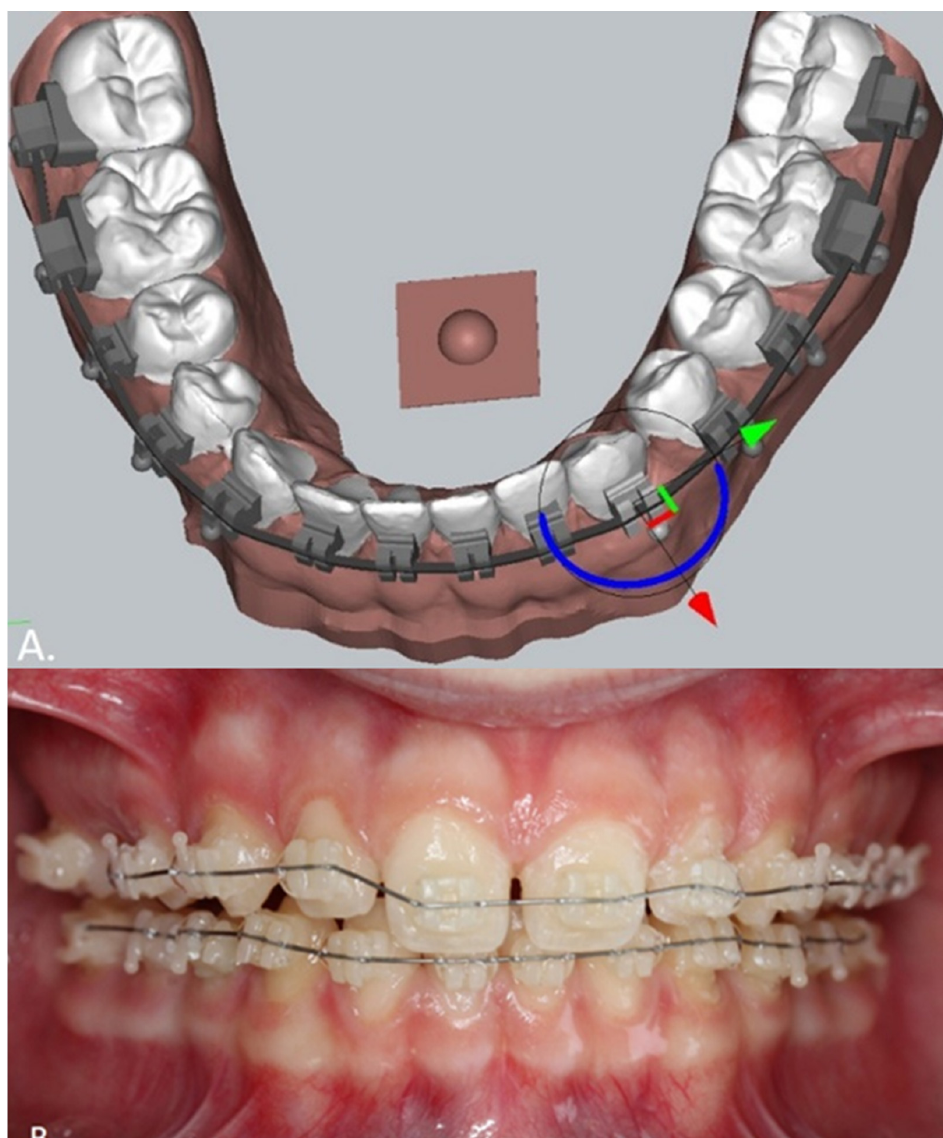
Figure 7. (A ) Setup and automatic positioning of customized brackets in Ubrackets software.